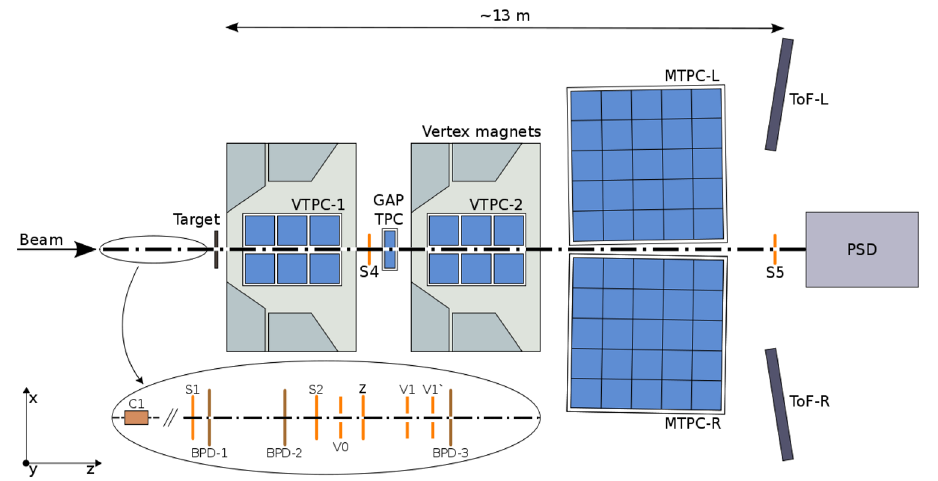
Fig. 1 The schematic layout of the NA61/SHINE experiment at the CERN SPS [1] showing the components used for the Be + Be energy scan(horizontalcut,nottoscale).Thebeaminstrumentationissketched in the inset. Alignment of the chosen coordinate system as shown in the